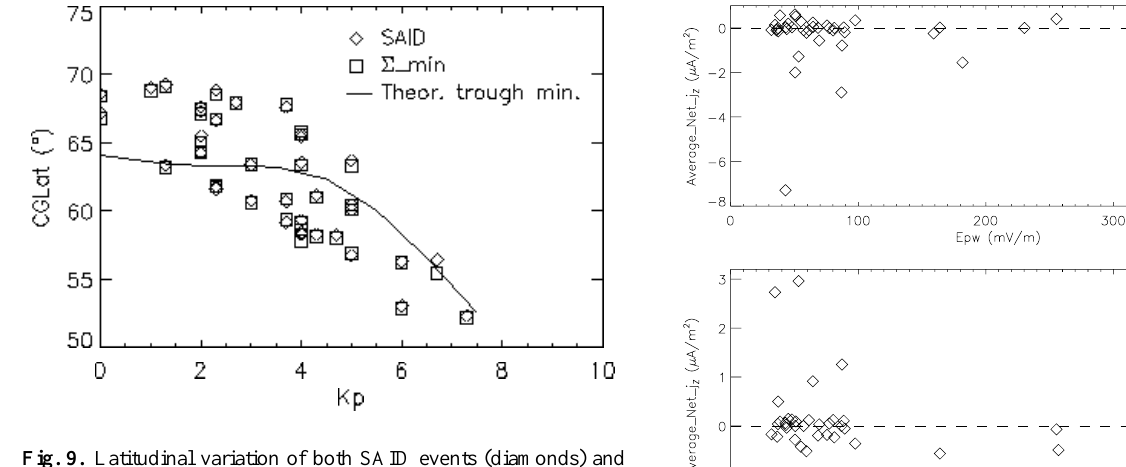
Fig. 9. Latitudinal variation of both SAID events (diamonds) and corresponding conductivity minimum (squares) positions versus magnetic activity index K p . The solid line represents the average position of the corresponding theoretical trough minimum.